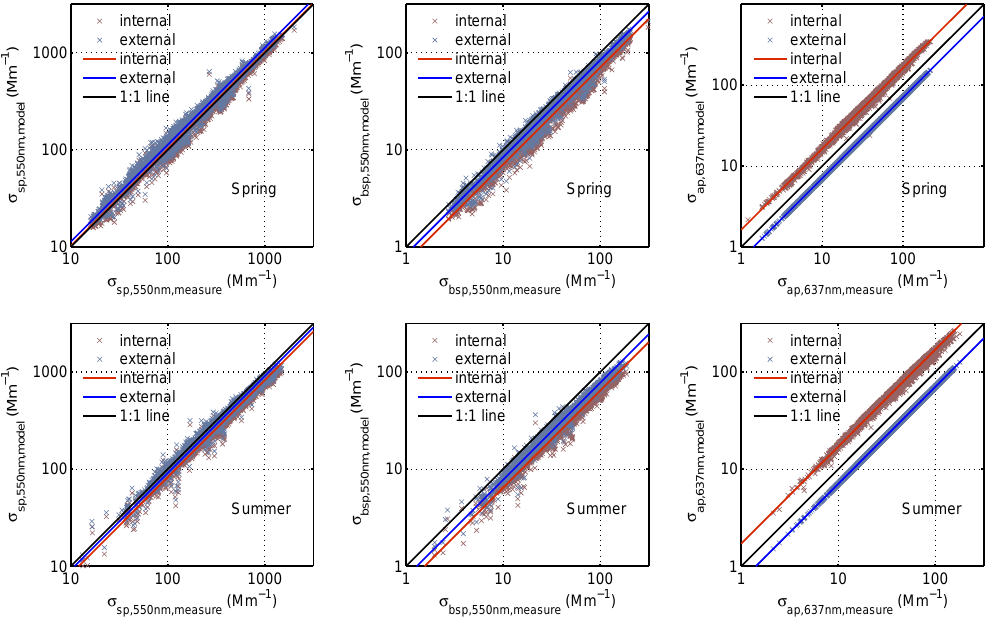
Fig. 6. Comparisons of measured and calculated σ sp , σ bsp and σ ap in log-scale coordinates, including the 1:1 reference lines. For σ sp and σ bsp , only the results at 550nm are shown. The straight lines represent the linear regression fittings to the data.